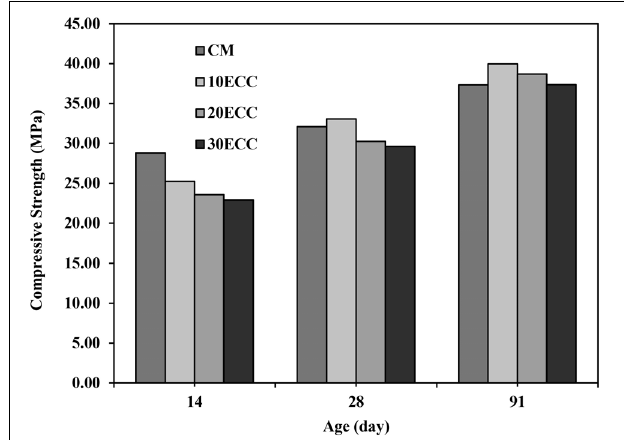
FIGURE 6 | Comparison of compressive strength with aging among CM and ECC mixes containing different percentages of